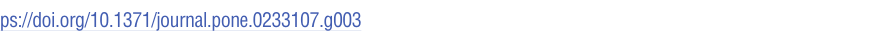
Fig 3. Scatterplot of 253 original and reproduced correlation effect sizes from 33 meta-analyses. All effect sizes are transformed to Fisher’s z